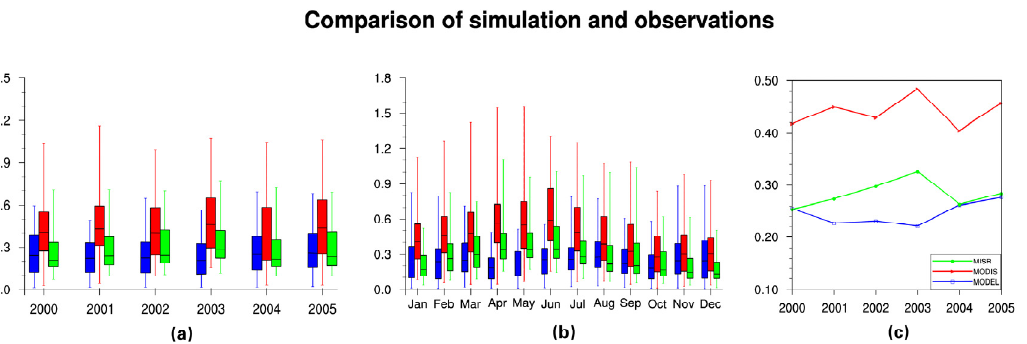
Figure 3. ( a ) Individual year averaged with error bar (blue—model, red—MODIS, green—MISR), ( b ) is the same with ( a ) but for monthly average. ( c ) is the year averaged AOD in 2000–2005.